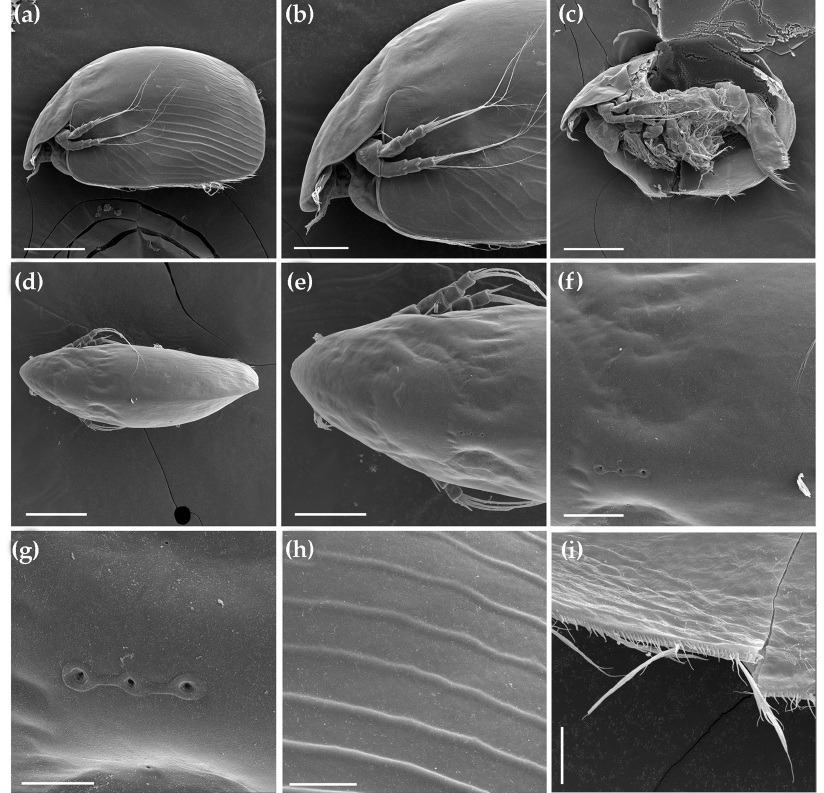
Figure 18. Coronatella anemae , an adult parthenogenetic female from Wadi Maidaq — Blue Pool, United Arab Emirates. ( a ) Female, lateral view; ( b ) head, lateral view; ( c ) dissected female, lateral view; ( d ) female, dorsal view; ( e ) head, dorsal view; ( f , g ) head pores; ( h ) ornamentation of posterior portion of valve, outer view; ( i ) armature of ventral margin of valve, inner view. Scale bars: 0.1 mm for (a,c , d ), 0.05 mm for ( b , e ), 0.02 mm for ( f , h ), 0.01 mm for ( g , i ).